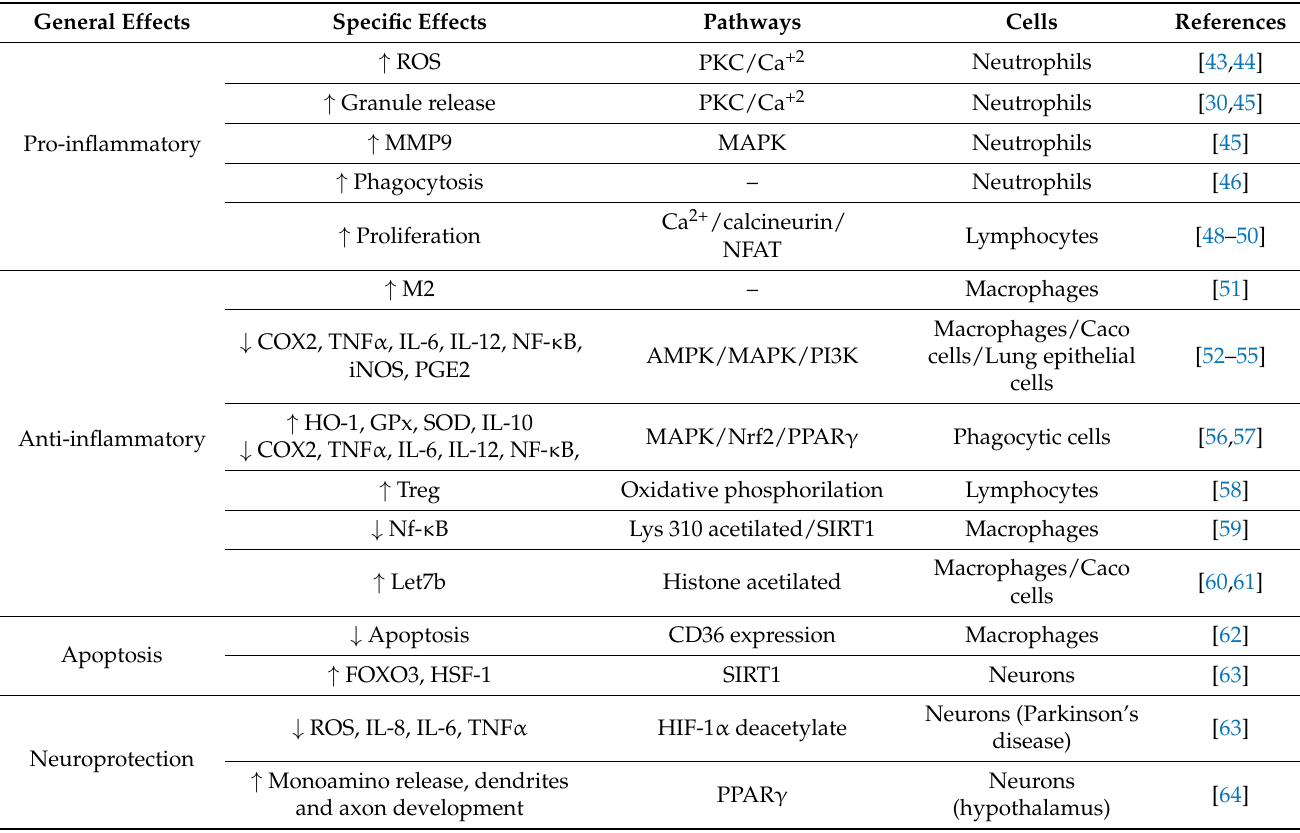
Table 1. Effects of oleic acid (OA) on signaling pathways, and types of immune cells